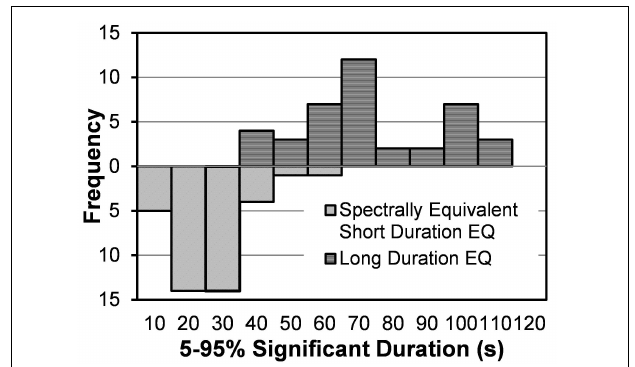
FIGURE 2 | Distribution of ground motion duration in the selected long and spectrally equivalent short duration